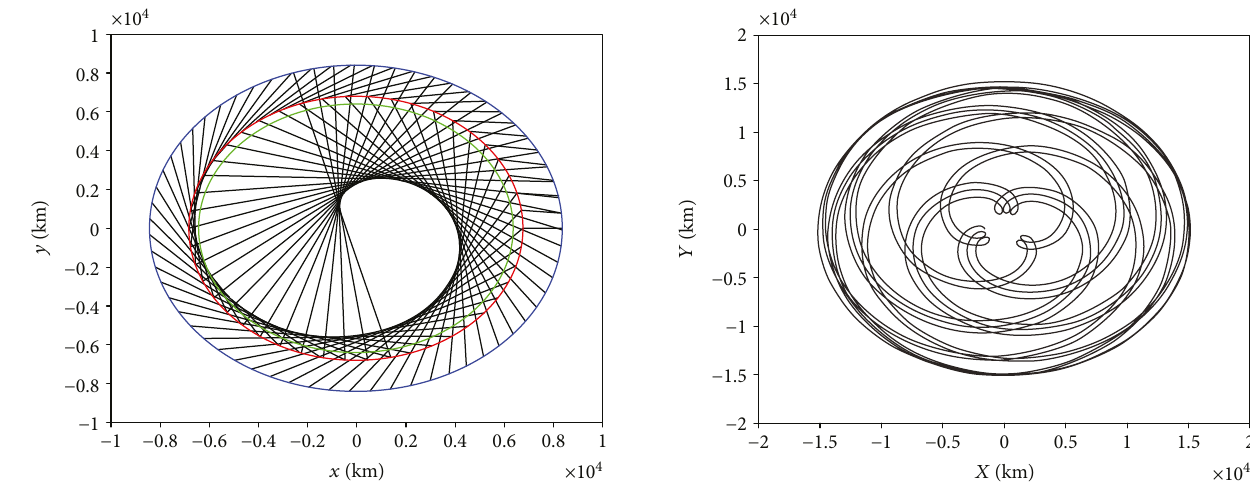
Figure 1: The fi rst eclipse of D (red) from S (blue) (two hours). Figure 2: Post-Newtonian relative orbit of D with respect to S (two